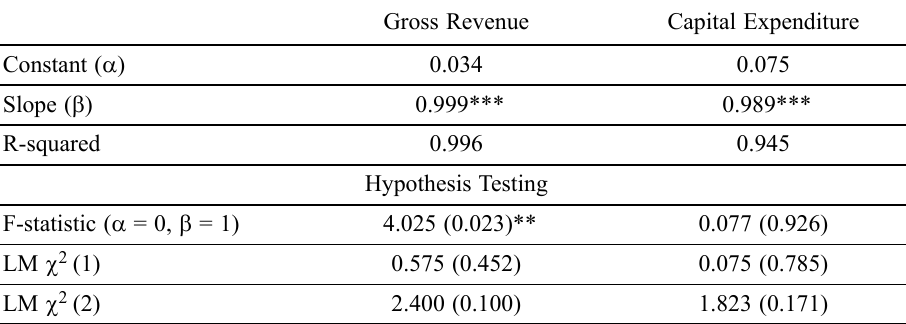
Table 2. Results of unbiasedness